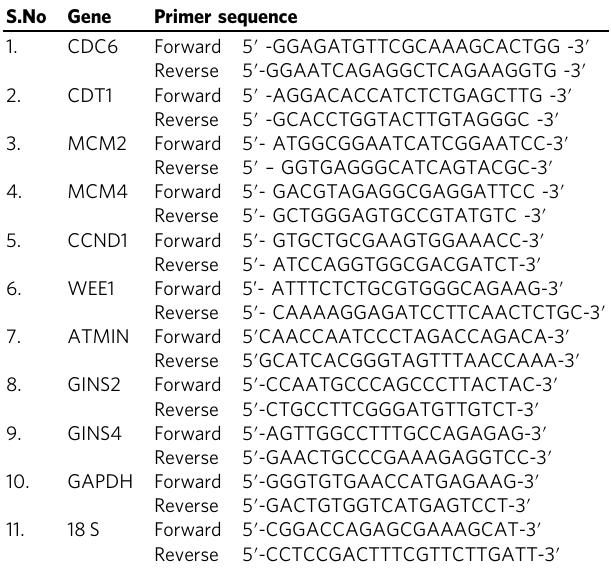
Fig. 6 CB blocks cell cycle progression and induces apoptosis in breast cancer cells. a Cell cycle distribution of vehicle and CB-treated MDA-MB-231 and